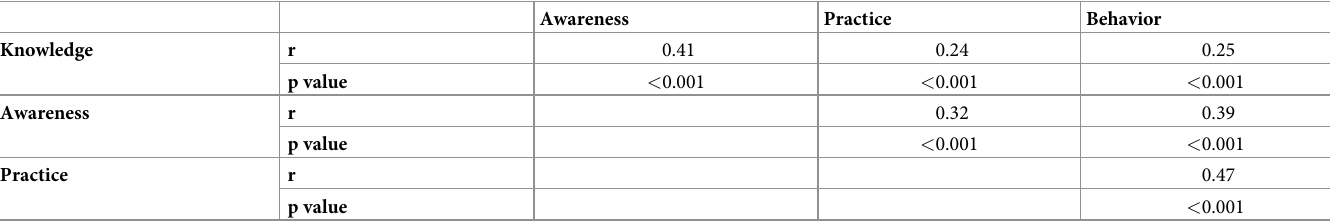
Table 7. The correlations of the knowledge, awareness, practice and behavior